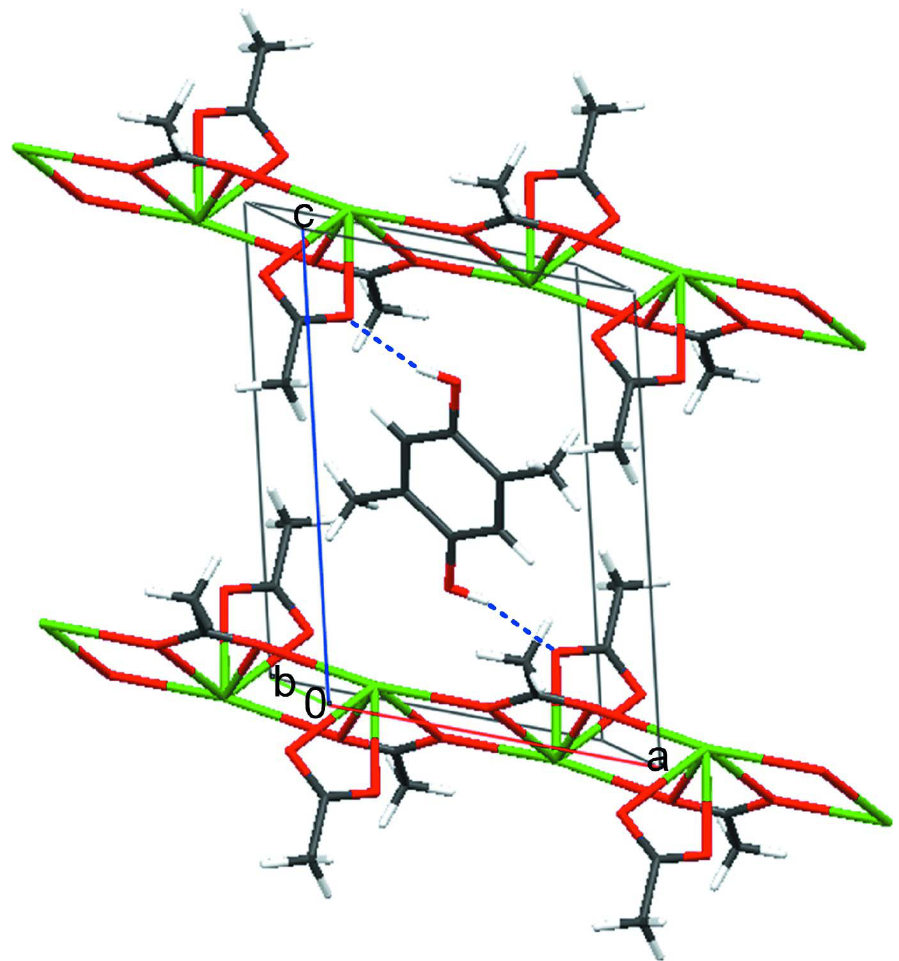
Figure 2 A packing diagram of the title compound. Hydrogen bonding is shown as blue dashed